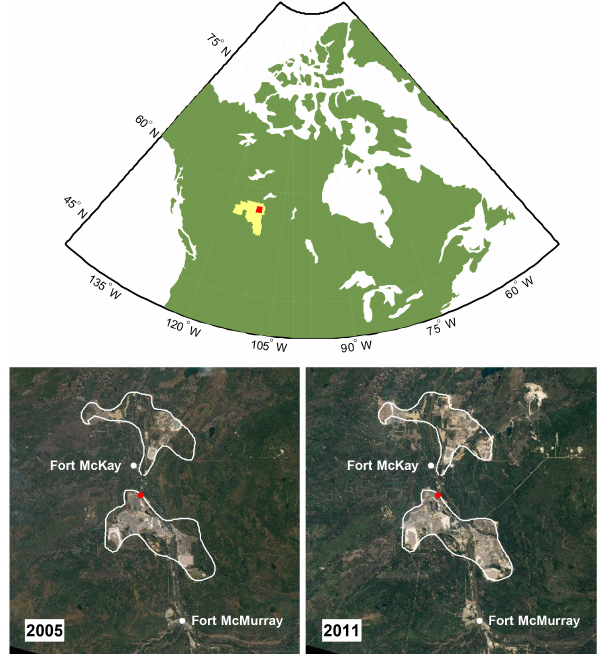
Fig. 1. (a) Map of the Canada showing the oil sands area (tan) and the location of the surface mining (red) which also corresponds to the area shown in panels (b) and (c) . Pan- els (b) and (c) show Landsat images from 2005 and 2011 of the surface mining area (http://earthobservatory.nasa.gov/Features/ WorldOfChange/athabasca.php?all=y). The white outlines denote the approximate boundaries of the main mining operations (as of 2011). The communities of Fort McMurray and Fort McKay are also indicated. The red dot denotes the reference location (57.1 ◦